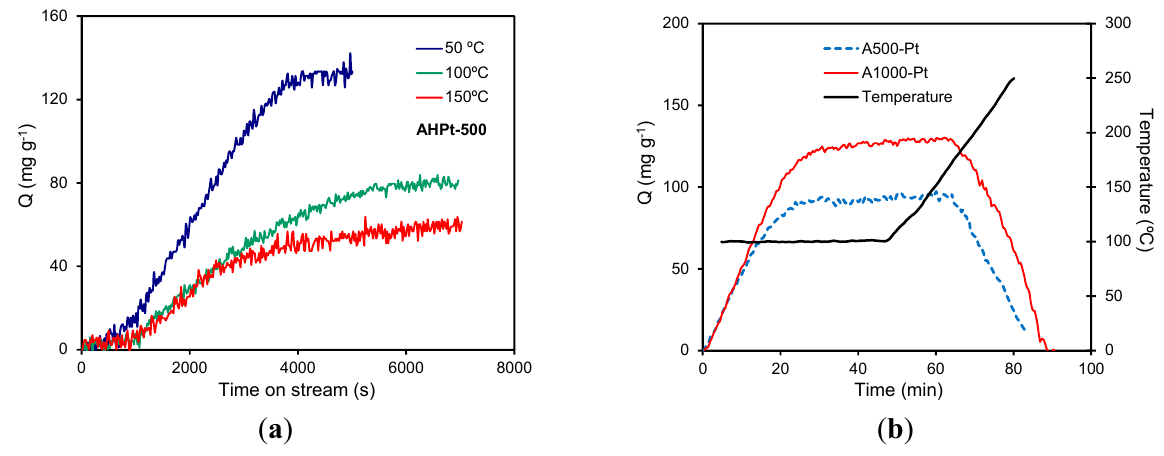
Figure 8. Dynamic toluene adsorption: ( a ) effect of the adsorption temperature and ( b ) effect of the carbonization temperature ( Q = 3.6 L h − 1 , 0.10 g catalyst ). Figures adapted with